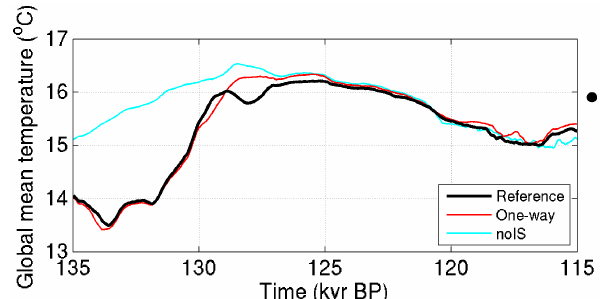
Figure 3. Global annual mean near-surface air temperature evo- lution of the reference run (black) compared to experiments with prescribed Greenland and Antarctic ice sheet evolution from stand- alone experiments (One-way, red) and no ice sheet changes at all (noIS, light blue). The filled circle on the right axis indicates the temperature for a pre-industrial control experiment of the reference model with present-day ice sheet configuration.